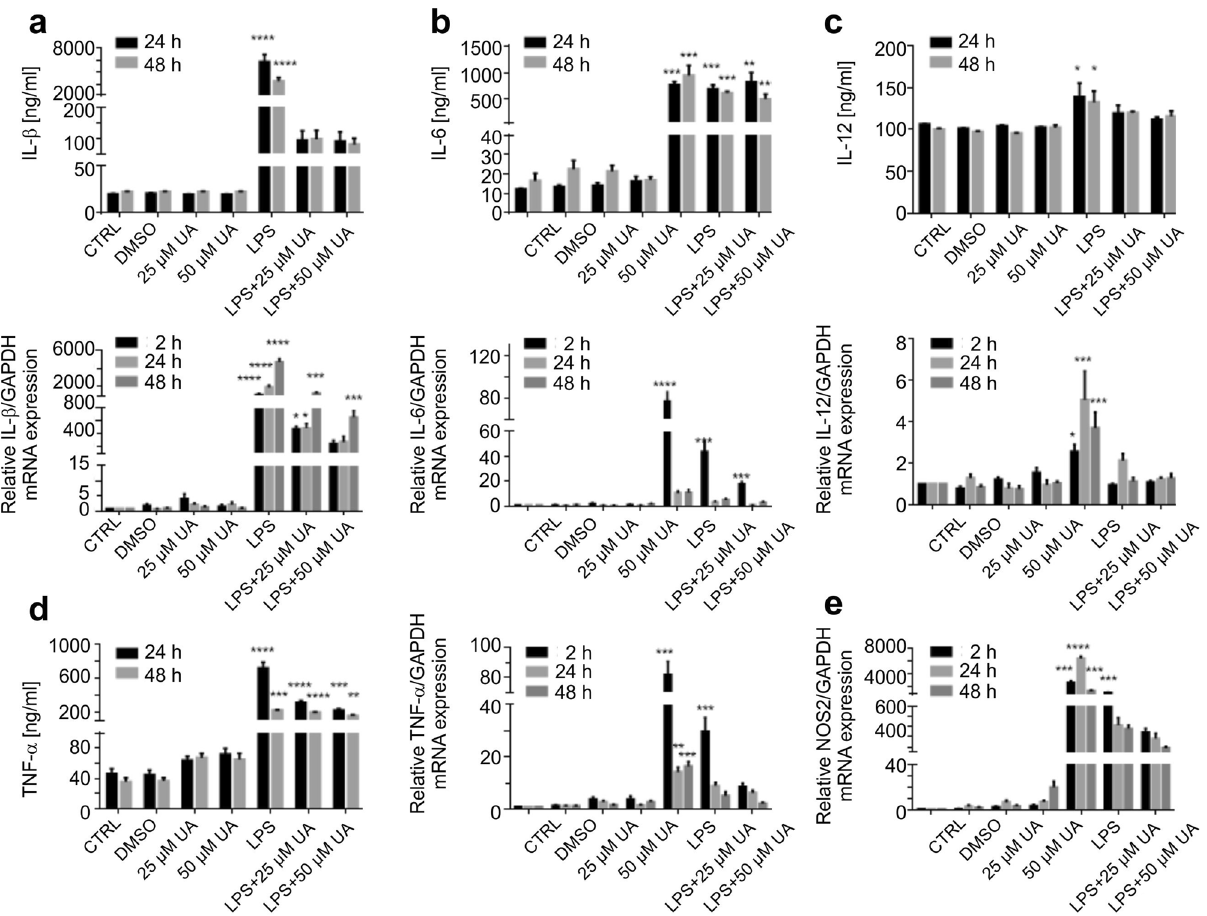
Figure 4. Urolithin A reduced the pro-inflammatory cytokine production and mRNA expression in LPS- stimulated murine BMDMs. Murine BMDMs were stimulated by 1 µg/ml of LPS in the presence or absence of UA (25 µM or 50 µM). Subsequently, expression of the pro-inflammatory cytokines IL-1β ( a ), IL-6 ( b ), IL-12 ( c ), TNF-α ( d ), and NOS2 ( e ) were measured in BMDMs by qRT-PCR (over GAPDH) and ELISA at depicted time points. The unstimulated and untreated BMDMs were used as control. BMDMs treated with DMSO were used as negative control. Arithmetic means ± SEM from seven independent experiments are depicted. Two way ANOVA was used and *( p < 0.05), **( P 0.01), ***( p < 0.001), and ****( p < 0.0001) indicate statistically significant differences compared to respective control. Abbreviations: DMSO, dimethyl sulfoxide; UA, urolithin A;